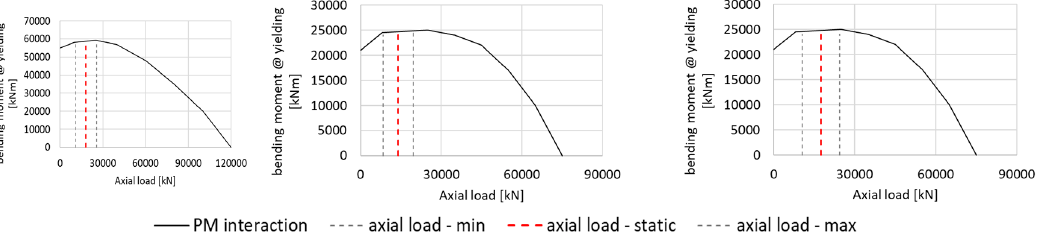
Figure 10. Axial load—bending moment @ yielding compared with a variation of axial load of ± 40%. From the top: Pier 1, Pier 2 and Pier 3.